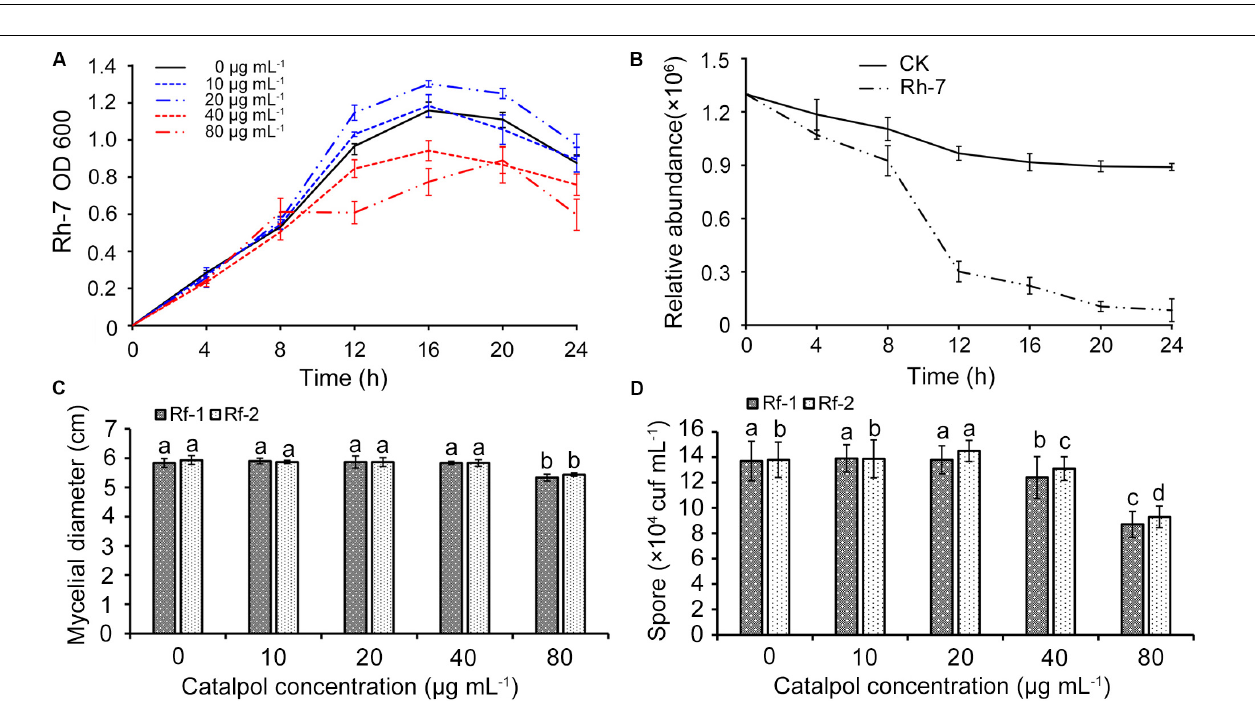
FIGURE 13 | Barplots for significantly different KO categories based on bacterial (A) and fungal (B) sequences. CKT1 and C represent soil amended catalpol, respectively.